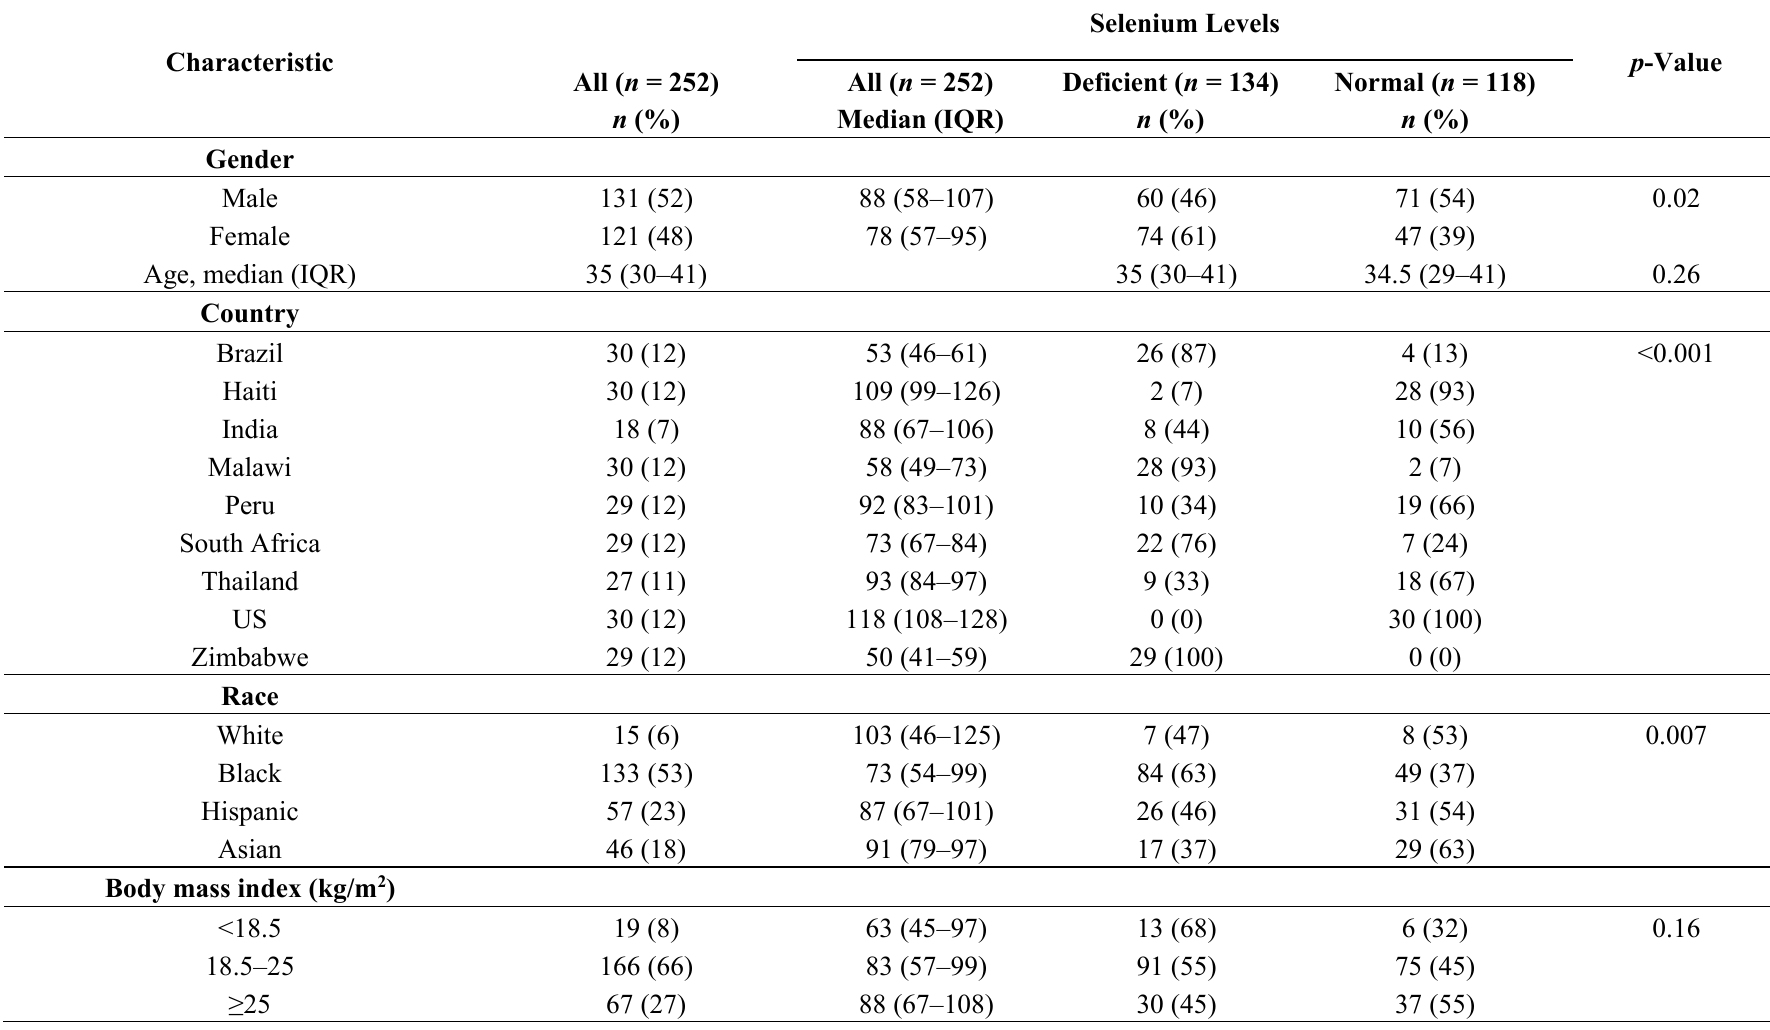
Table 1. Characteristics of study population by serum selenium deficiency (<85 μg/L)